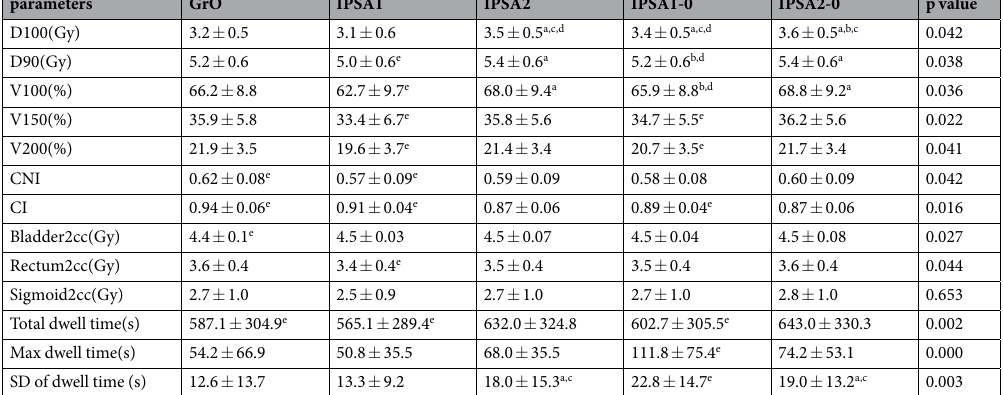
Table 1. Comparison of results with each plan. Results are mean ± 1 standard deviation. a Significantly different from the GrO. b Significantly different from the IPSA2. c Significantly different from the IPSA1. d Significantly different from the IPSA2-0. e Significantly different from all other plans.